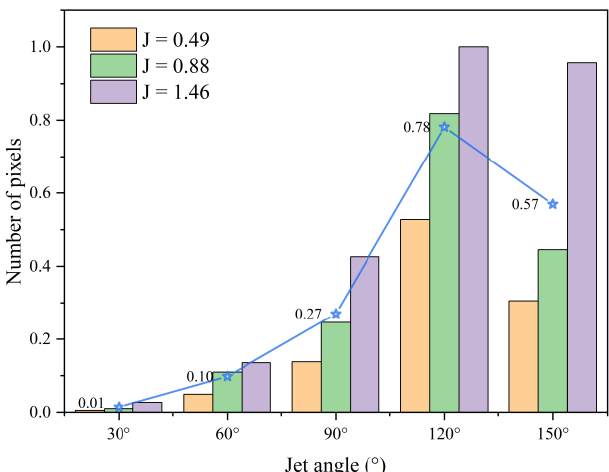
Figure 16. Area of the strong fluctuation regions for different jet angles and momentum flux ratios.